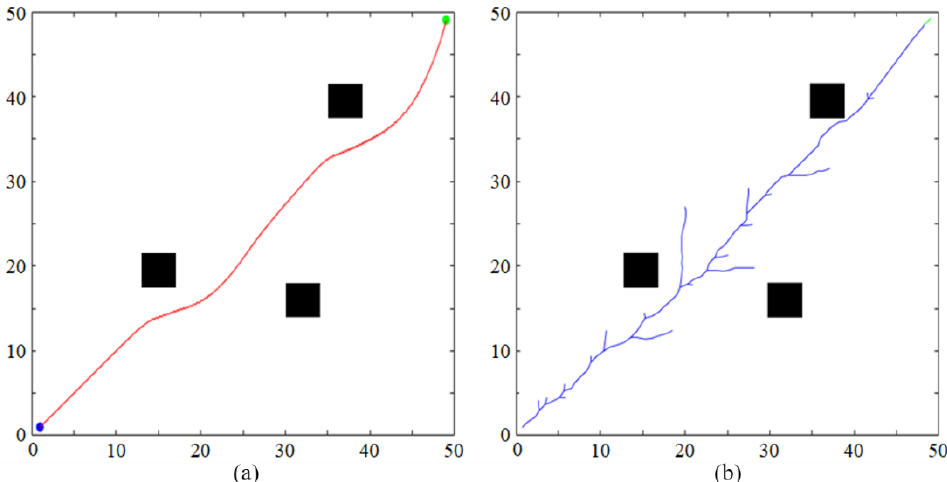
Figure 5. A comparison of the APF algorithm and APF-IRRT* algorithm in a simulated example. ( a ) shows the simulation result of APF algorithm. ( b ) shows the simulation result of APF-IRRT* algo- rithm.